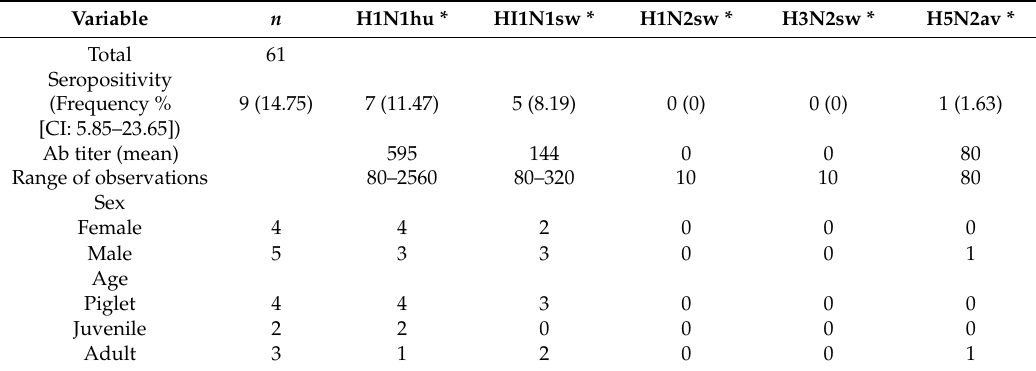
Table 1. Count of wild pig serum samples positive to the hemagglutination inhibition assay for at least one influenza A virus subtype. Seropositivity, frequency, antibody titer, sex, and age are shown for the total population sampled and for the five influenza subtypes used in the assay.